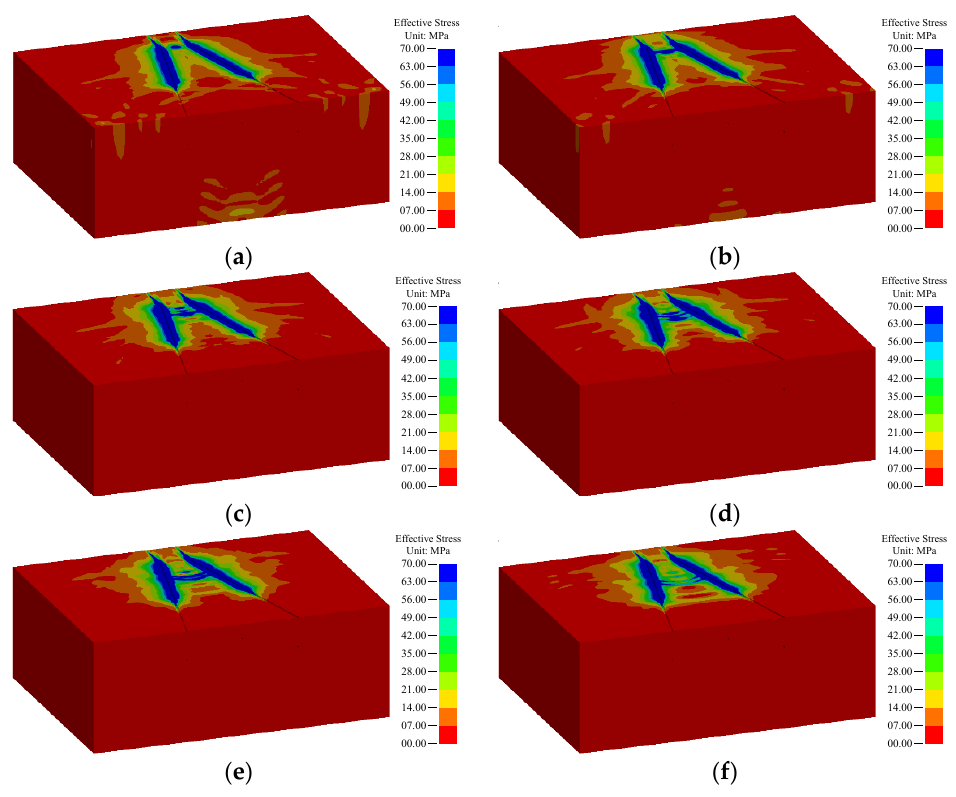
Figure 7. Dynamic evolution process of stress wave after charge detonation in center holes: ( a ) 1050 µs, ( b ) 1100 µs, ( c ) 1150 µs, ( d ) 1200 µs, ( e ) 1250 µs, and ( f ) 1300 µs.